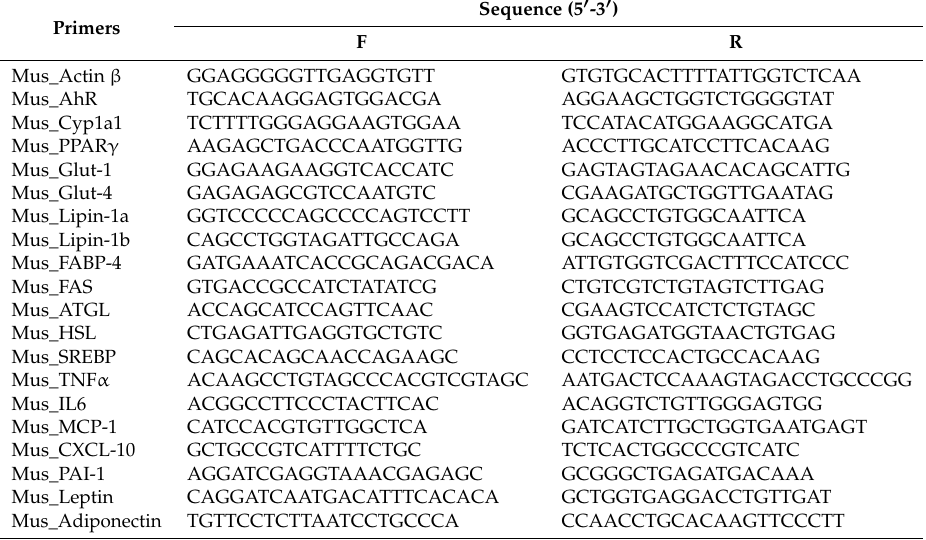
Table 2. Sequences of primers used in qRT-PCR analyses. F: forward; R: reverse.